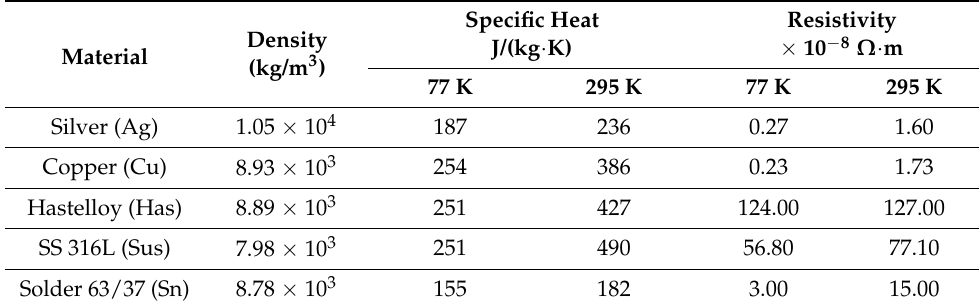
Table 1. Material